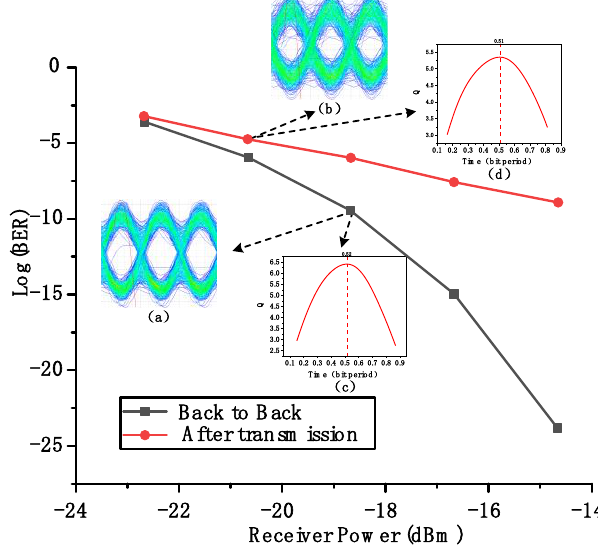
Fig.3. BER performance of MSK signal; (a) The eye diagram in the back-to-back; (b) The eye diagram after transmission; (c) Q factor and 1-bit period relationship curve of back-to-back transmission; (d) IQ factor and 1-bit period relationship curve of after